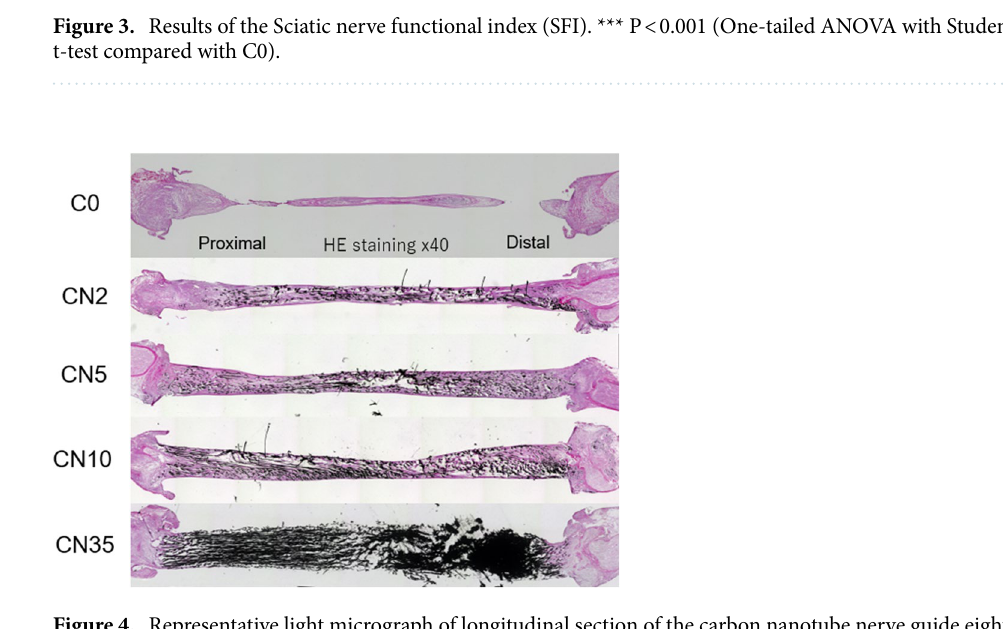
Figure 4. Representative light micrograph of longitudinal section of the carbon nanotube nerve guide eight weeks after sciatic injury and repair with hematoxylin and eosin